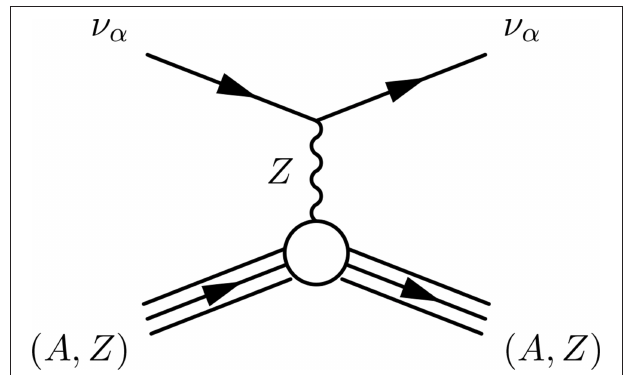
FIGURE 1 | Feynman diagram illustrating the tree-level SM CE ν NS